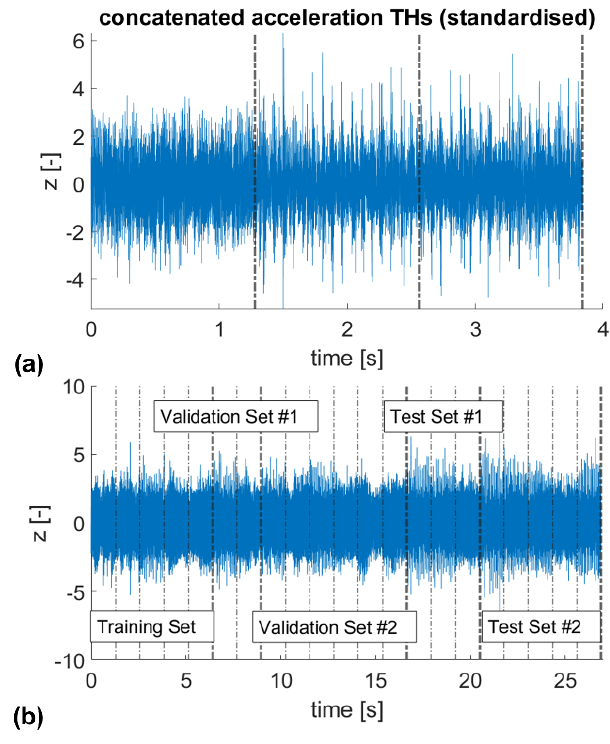
Figure 2. The investigated signals: ( a ) #1, ( b ) #2. Data standardised as 𝑧(𝑡) = (ℎ(𝑡) − 𝜇(ℎ(𝑡)))/𝜎(ℎ(𝑡)) . In ( a ), the dot-dashed vertical lines represent the three concatenated segments. In ( b ), the thick dot-dashed vertical lines enclose the segments considered for the training set, the two validation sets, and the two test sets, in this order (see Table 1). The single segments are separated by thin vertical lines. Table 1. The concatenated recordings, as reported in the experimental database 1 .